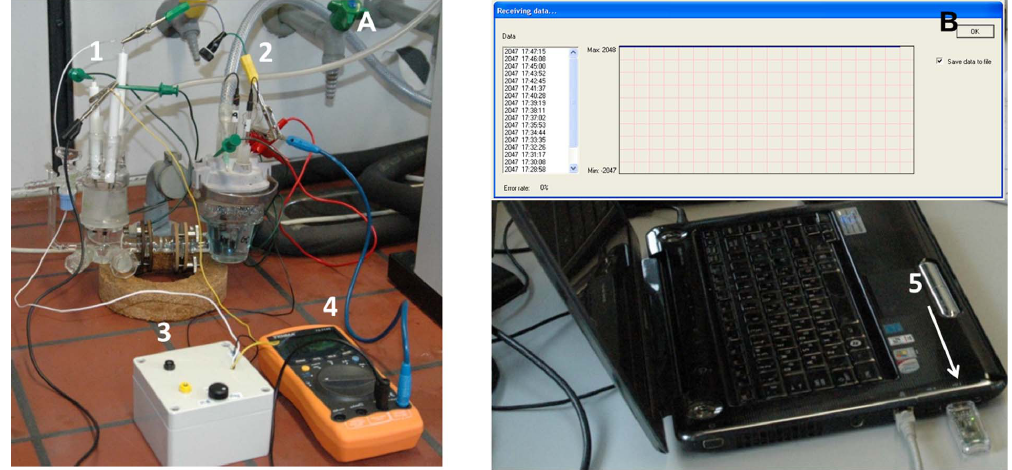
Figure 2. Bench-top device test. Photographs of the set-up for the bench-top device test, showing (A) the oxygen sensitive wireless self-powered biodevice, i.e. an EFC (electrochemical cell containing the anodes, 1, and cathodes, 2) connected to the wireless operational unit (white box, 3) and a control device (voltmeter, 4) and (B) a computer with the developed control software and receiver (CC2530 radio highlighted with the white arrow, 5), placed roughly 4 m from the device.